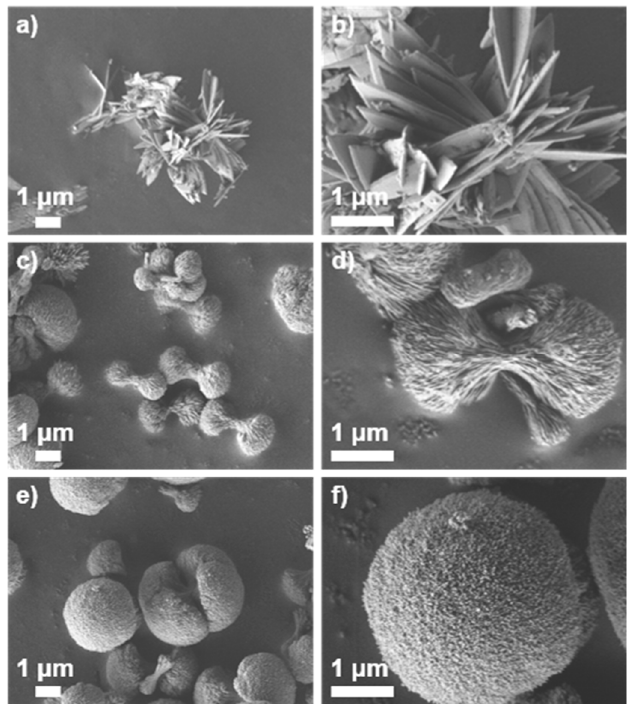
Figure 3. Scanning electron microscopy (SEM) images of LCP- Cmcm prepared by different procedures. ( a , b ) Solvothermal synthesis; ( c , d ) Polyol synthesis; Addition of H 3 PO 4 to LiAc solution and posterior addition of CoAc 2 to H 3 PO 4 /LiAc mixture; ( e , f ) Polyol variation on the order of mixture: First mixture of CoAc 2 and LiAc with posterior addition of H 3 PO 4 to the CoAc 2 /LiAc mixture.